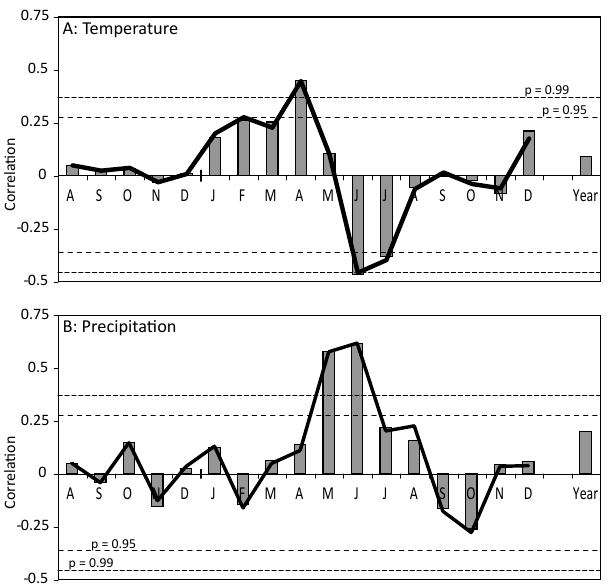
Fig. 6. Correlations (bars) and response functions of monthly aver- age temperatures (A) and precipitation sums (B) with yearly growth indices of the all tree chronology.